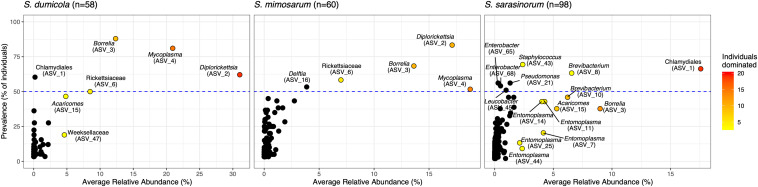
Prevalence and average relative abundance of ASVs in the three social Stegodyphus species (presence threshold: relative abundance ≥ 0.01%). Colored circles depict dominant ASVs; the color scale shows the number of animals in which a given ASV had a relative abundance of more than 30%. The horizontal dashed line indicates 50% prevalence; ASVs above the line are included in the core microbiome of the respective spider species.